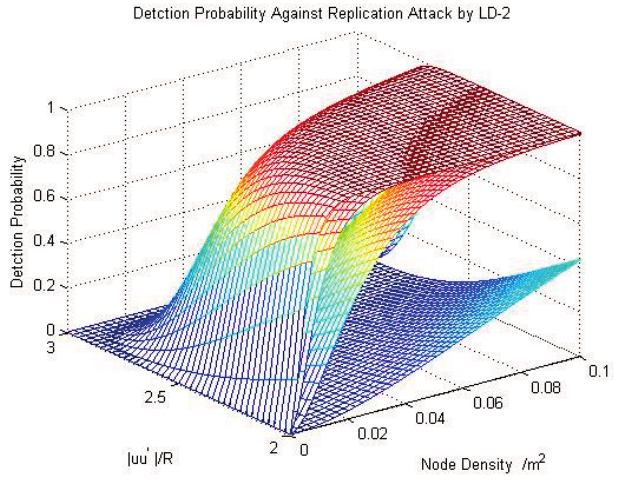
Figure 5. The result of detection probability for resisting a replication attack by using